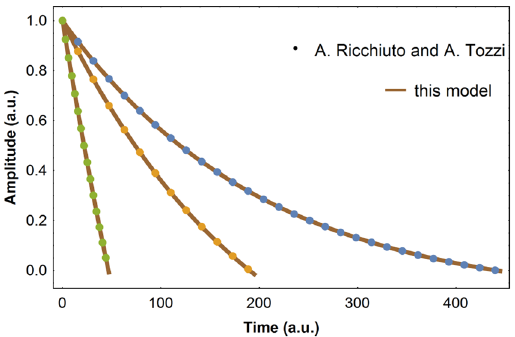
Figure 2. Oscillator amplitude versus time. The oscillator is submitted to three different sliding friction forces. The amplitude decay is exponential with a negative